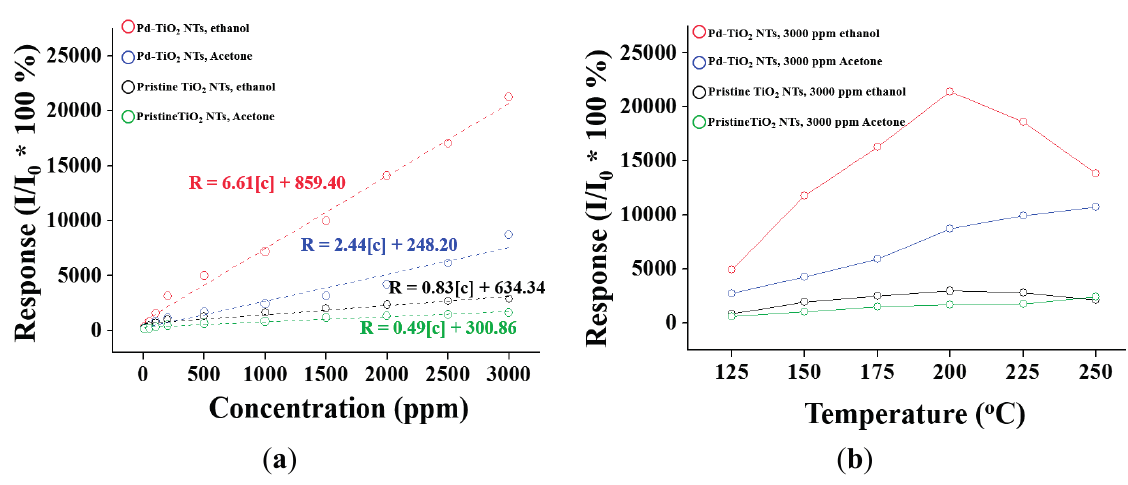
Figure 3. ( a ) Responses of pristine and Pd-functionalized TiO or acetone gas as a function of the ethanol or acetone concentration; ( b ) Responses of pristine and Pd-functionalized TiO of